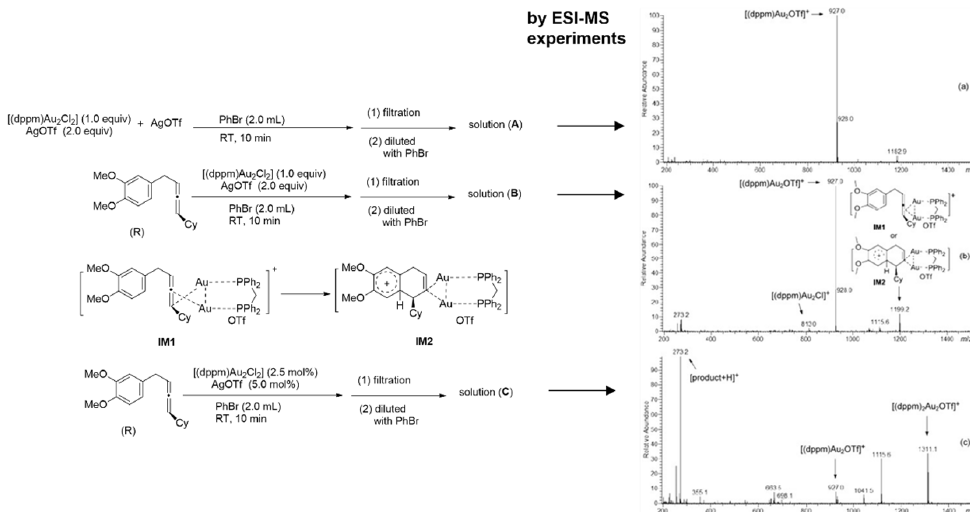
Figure 2 . ESI-MS experiments to investigate the active intermediate of catalytic system. Reproduced with permission of [14]. MS spectrum ( a ) refers to solution A and shows the presence of ion [(dppm)Au 2 OTf] + at m / z 927.0; MS spectrum ( b ) refers to solution B and shows the presence of dinuclear gold ion at m / z 1199.2 corresponding to the two possible intermediates IM1 and IM2; MS spectrum ( c ) refers to solution C. In this case, the analysis has been performed after 8h and shows the presence of the reaction product along with the active intermediate.